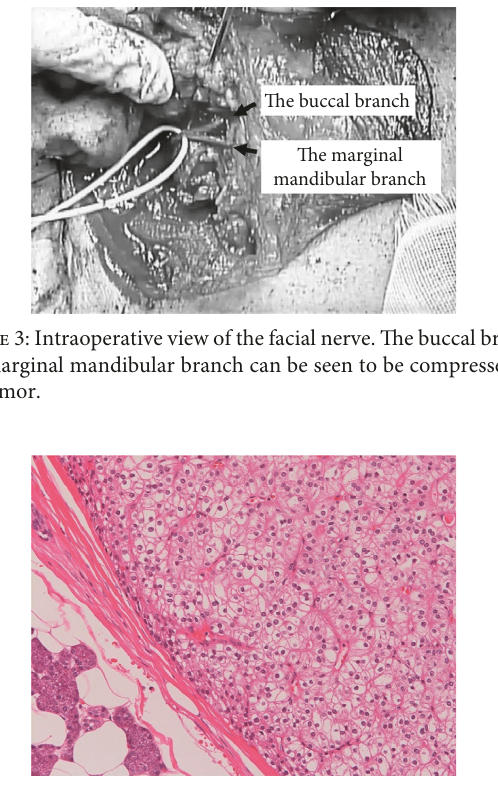
Figure 4: Frozen section of the neoplasm. Clear cells can be seen to form a clear boundary between the normal parotid gland tissues (haematoxylin-eosin, ×